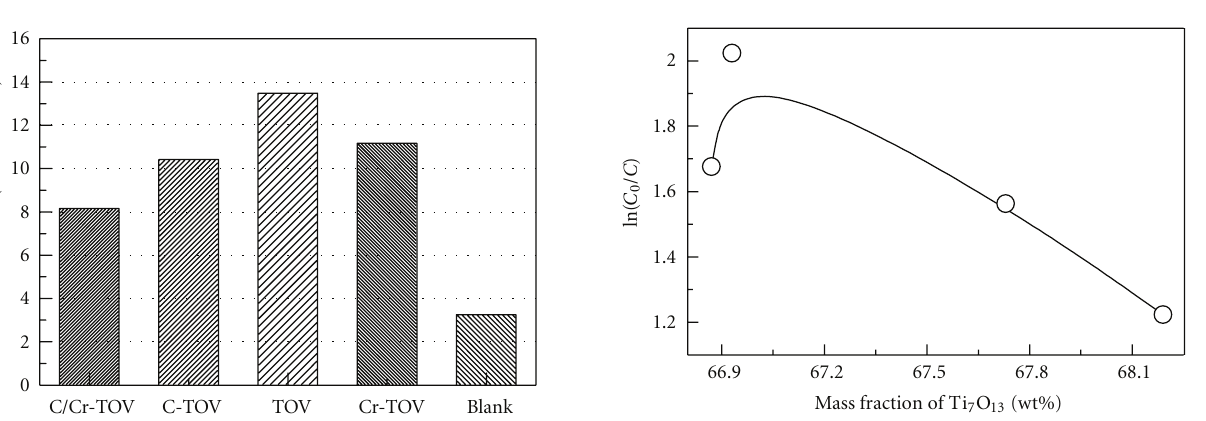
Figure 5: The comparison of reaction constant of di ff erent samples. Figure 6: The photocatalytic activity as a function of the mass fraction of Ti 7 O 13